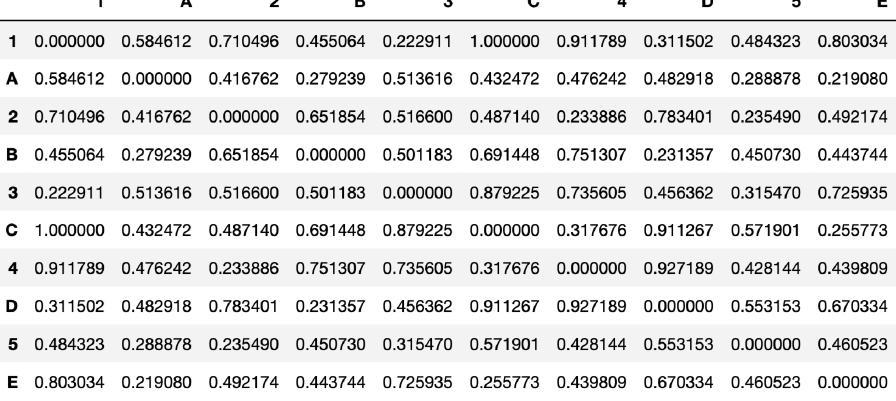
Figure 4. Distance matrix.